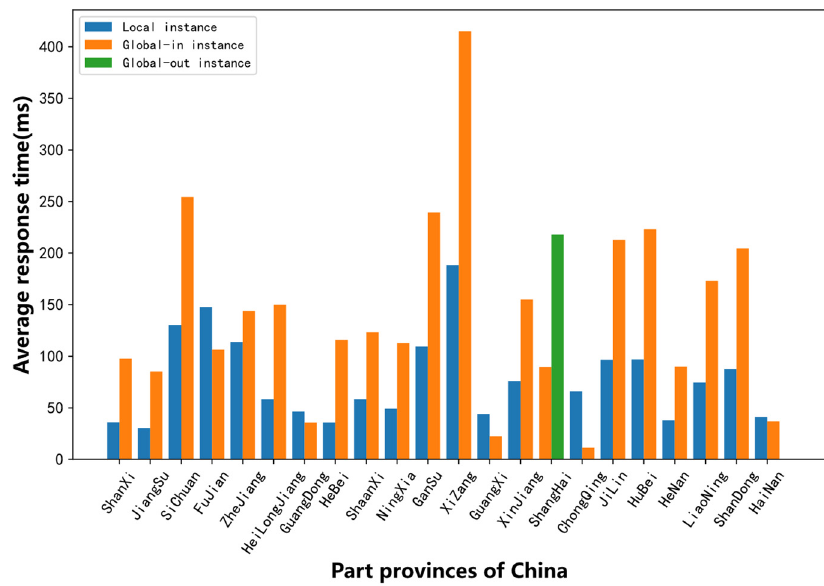
Figure 11. Average response times of three type nodes of K root in different